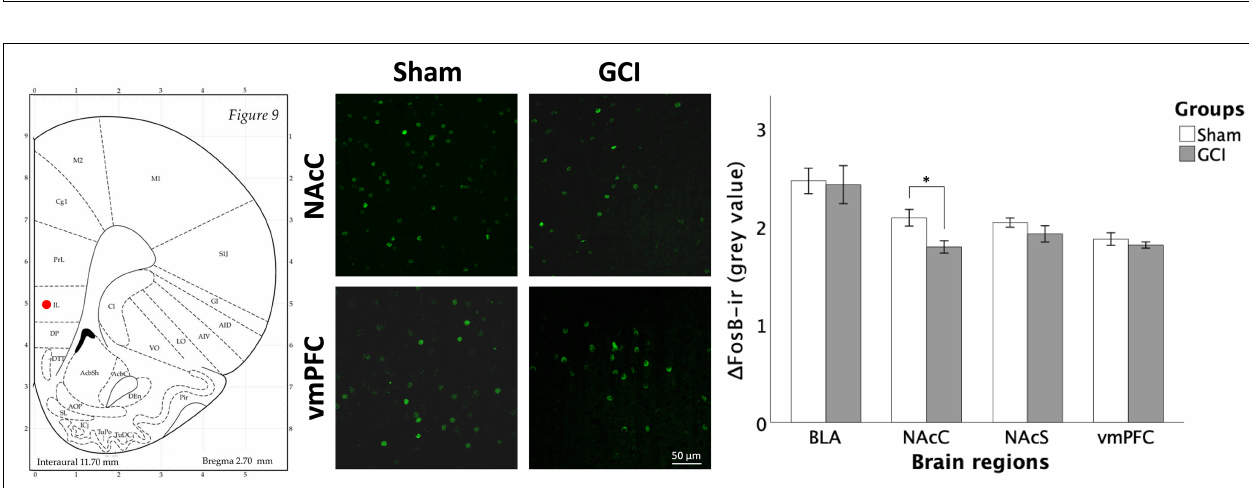
FIGURE 8 | Dopamine receptor D 2 fluorescence immunohistochemistry following global cerebral ischemia. Figure shows representative fluorescence photomicrographs of dopamine receptor D 2 (DRD 2 ) expression at 20 × magnification in the basolateral amygdala (BLA) and NAcS of rats having undergone sham surgery or GCI. Histogram presents mean grey value for DRD 2 immunoreactivity in each brain region of interest. Values are presented as mean ± S.E.M. ∗ Indicates statistical significance at p < 0.05. Visual representation of rat brain adapted from labs.gaidi.ca/rat-brain-atlas/ (Paxinos and Watson, 2006). GCI, global cerebral ischemia; NAcC, nucleus accumbens core; vmPFC, ventromedial prefrontal cortex.